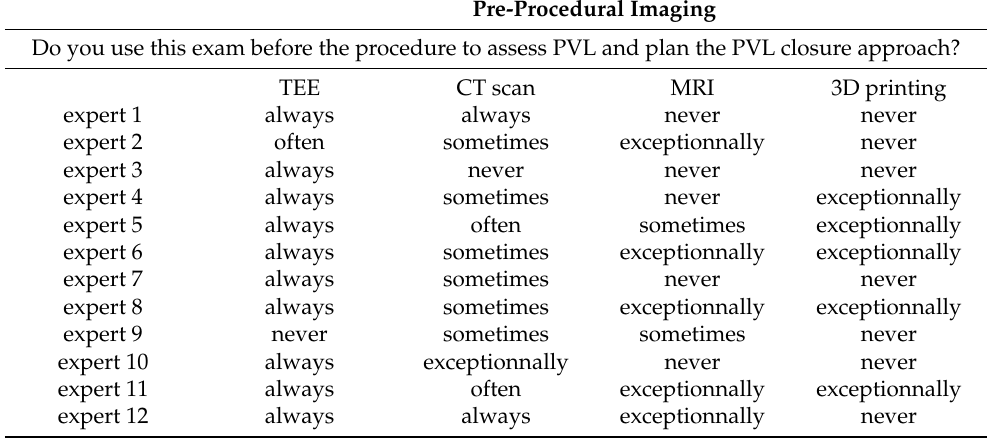
Table 1. Imaging methods used to assess paravalvular leaks. TEE: trans-oesophageal route; CT: Computed Tomography; MRI: Magnetic Resonance Imaging. Pre-Procedural